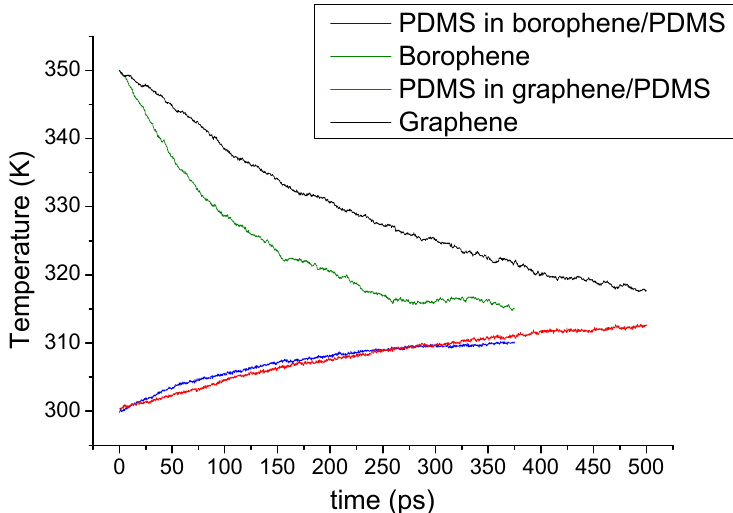
Figure 2. Time-averaged temperatures recorded during the heat transfer simulations for the six-layer nanosheets of graphene and borophene over the PDMS polymer.